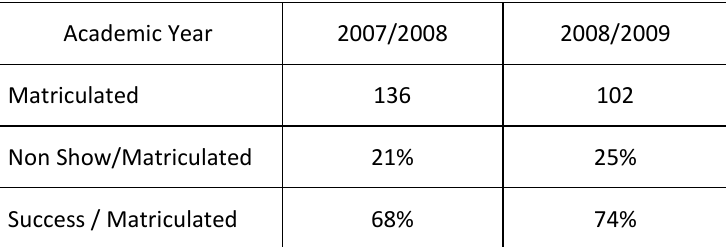
Table 3: Figures for the last two